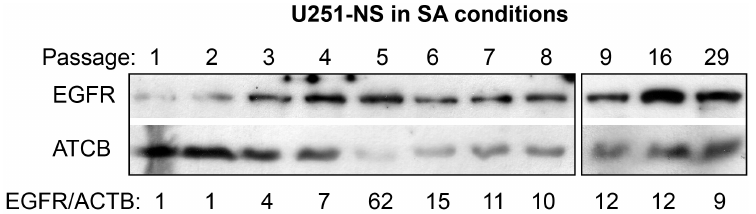
Figure 5. Increase in EGFR expression in U251-NS serial passed in SA-conditions. Whole cell lysates (40 mg) extracted from cell pellets frozen at − 80 °C were electrophoresed and immunoblotted with antibodies for EGFR and ACTB. Cells were cultured for three days from the same seeding density (5 × 10 5 /100 mm dish) and subjected to one-day serum-free culture prior to being frozen for protein analysis. Increased EGFR protein expression was detected as early as passage 3 in response to changes of culture condition.